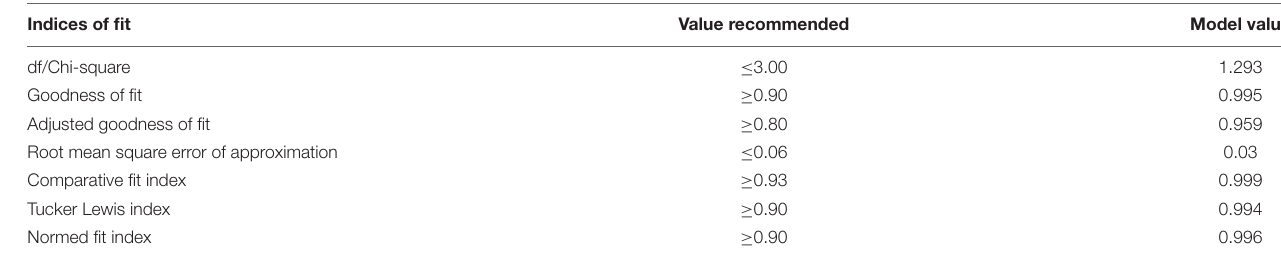
TABLE 10 | Fit indices for the